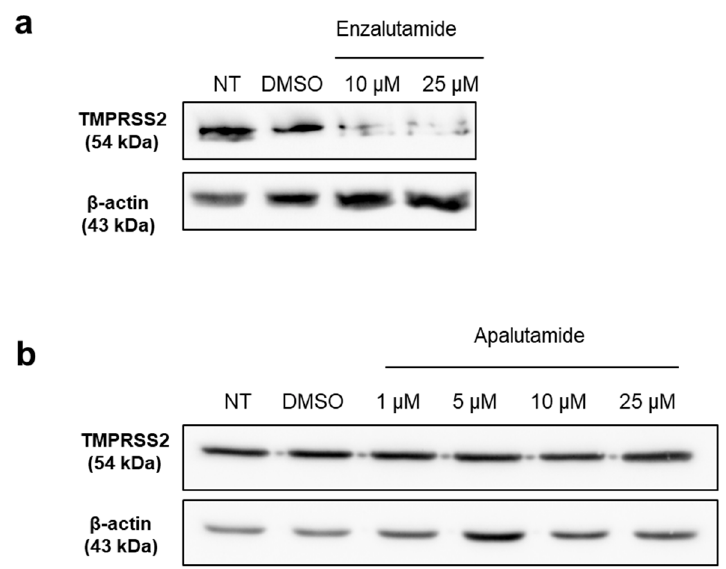
Figure 3. Effect of AR antagonists on TMPRSS2 expression in lung cells. ( a ) Western blot analysis of TMPRSS2 and β -actin in Calu-3 cells treated with enzalutamide at 10 or 25 µM for 72 h; ( b ) Western blot analysis of TMPRSS2 and β -actin in Calu-3 cells treated with apalutamide at 1, 5, 10 or 25 µM for 72 h.